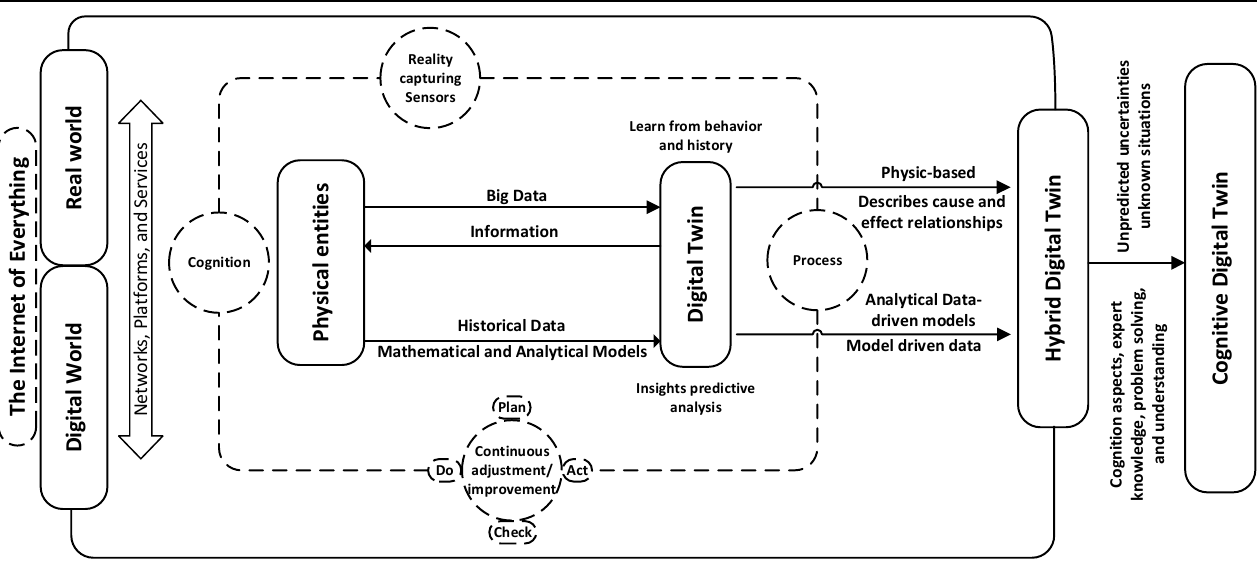
Figure 2. Different stages of Digital Twins to Cognitive Digital Twins.